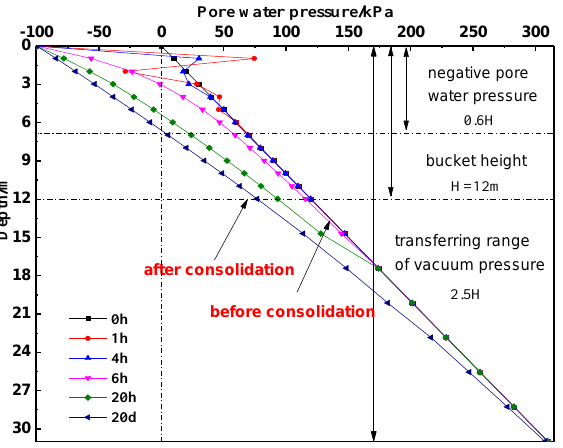
Figure 9. Variations of pore water pressure with depth at different times for bucket foundation with bulkheads.